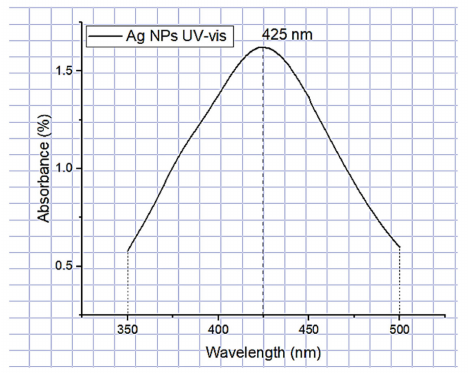
Figure 1. UV-vis of